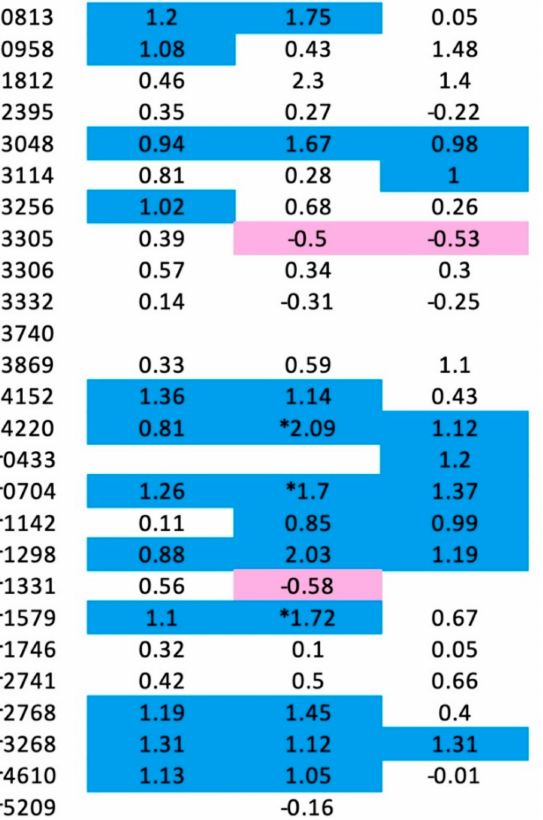
Figure 20. Summary of PRP gene expression in Nostoc sp st PCC 7120 following nitrogen deprivation. The numbers indicate the log base 2 of the relative change following nitrogen deprivation relative to the 0 h time point. Positive values indicate increased expression and negative values indicate decreased expression. Values shaded in blue indicate at least a twofold increase in expression. Values marked by an asterisk (*) indicate statistically significant changes. Values shaded in pink indicate at least a 40% decrease in expression. Values were obtained from the supplementary tables reported by Ehira and Omori